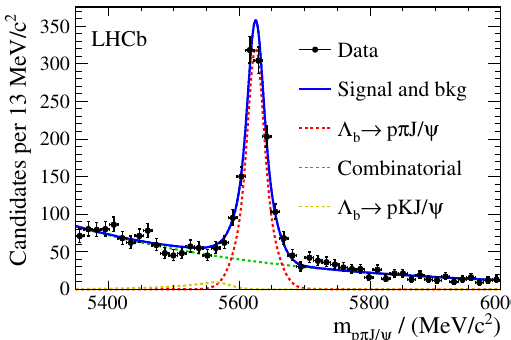
Figure 2 . Mass distribution of (cid:3) 0 J= p(cid:25) (cid:0) candidates compared to the result of the (cid:12)t. The (cid:12)t b ! parameterisation is described in the